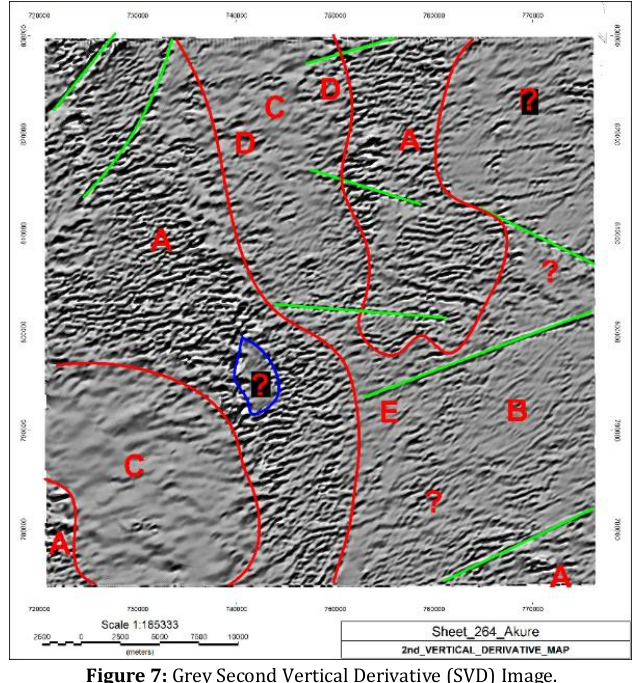
Figure 7: Grey Second Vertical Derivative (SVD) Image.